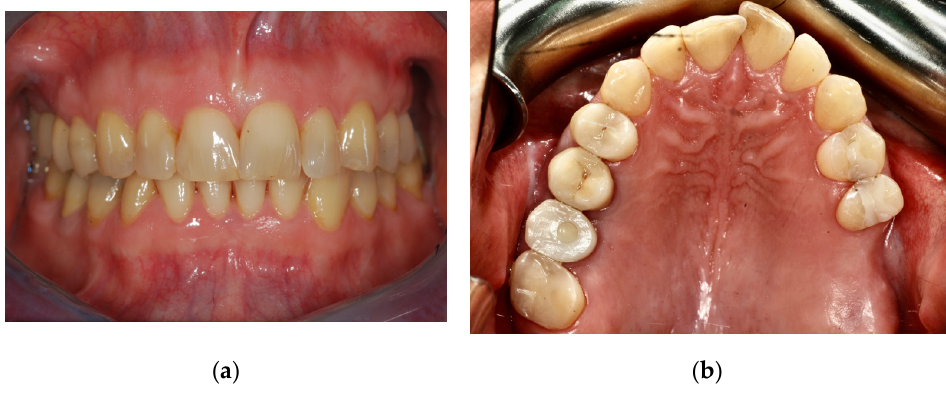
Figure 1. Preoperative records: ( a ) frontal view; ( b ) occlusal view.